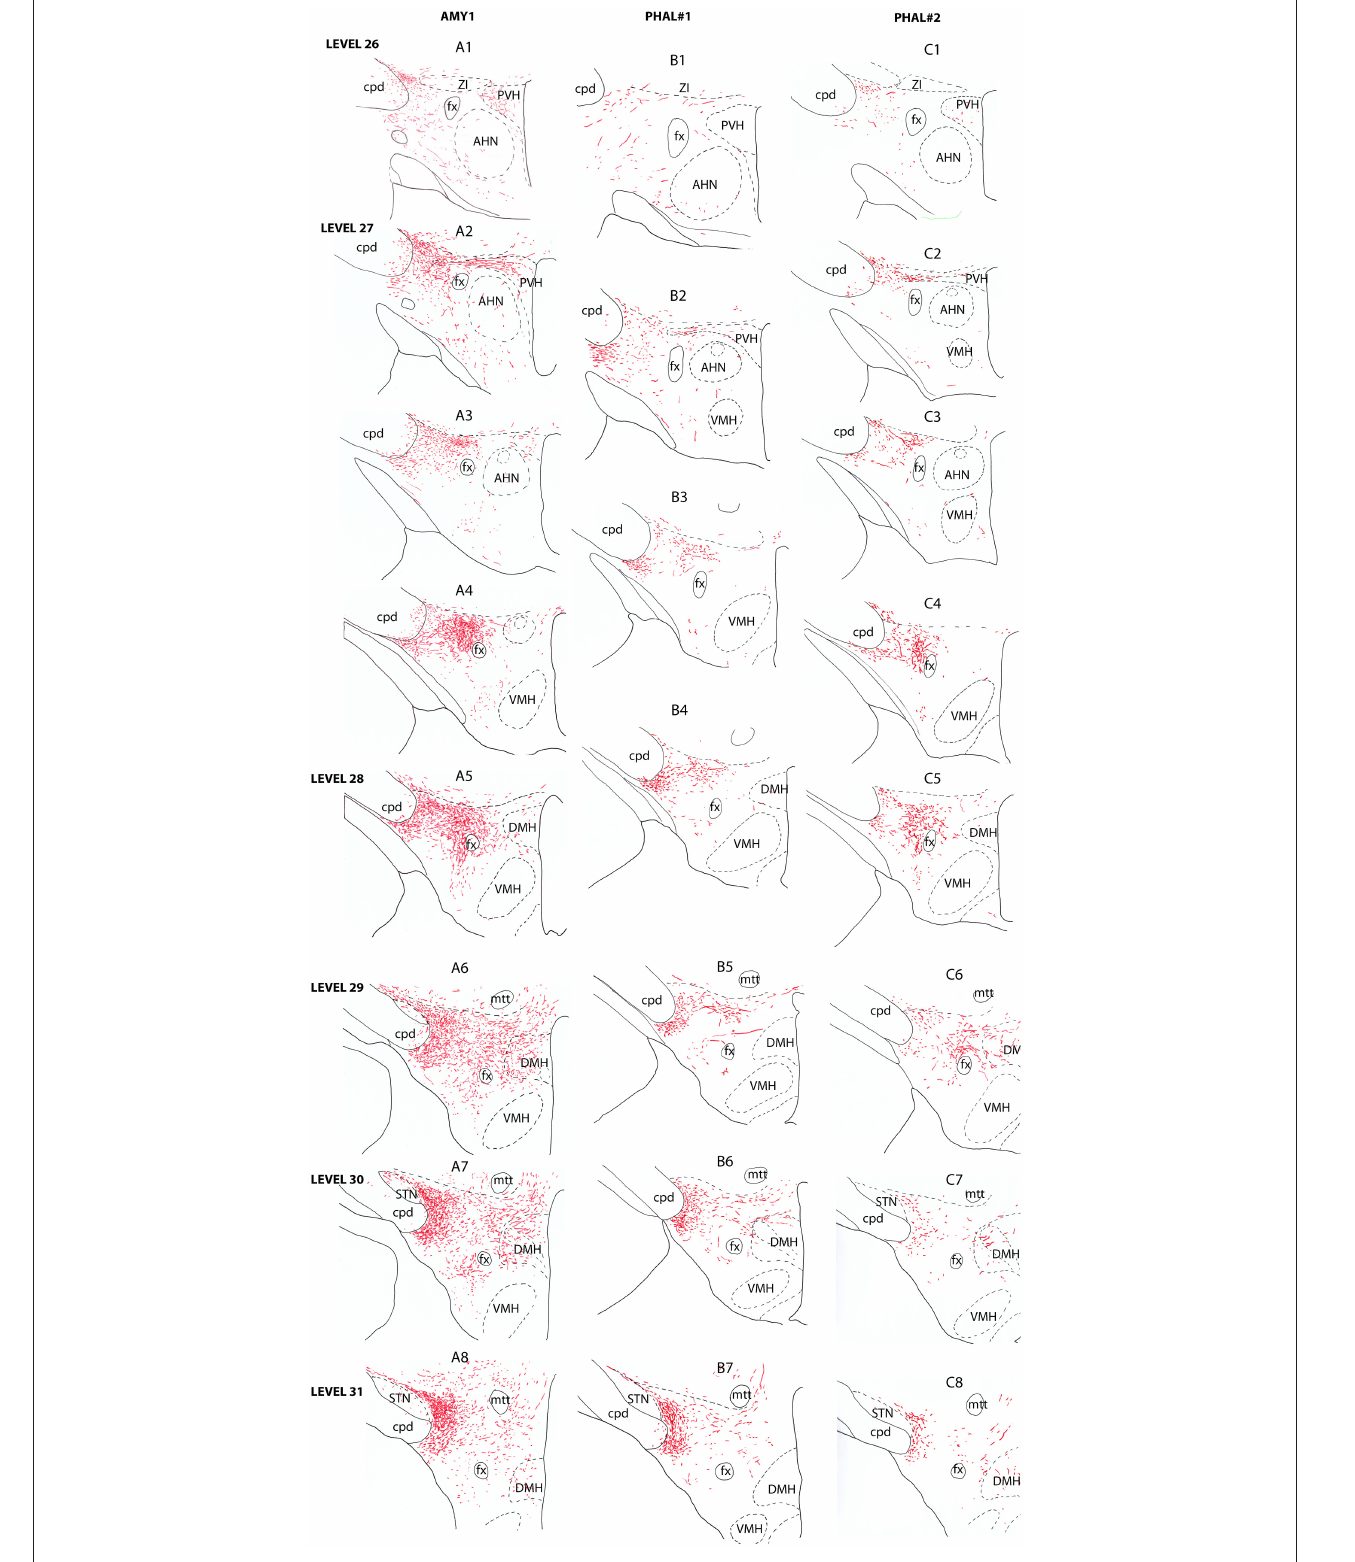
FIGURE 2 | Line drawings describing the distribution patterns of PHAL axons in the LHA of sections corresponding to the levels 26–31 of the Swanson’s Brain Maps (28) in experiments AMY1, PHAL#1, and PHAL#2.